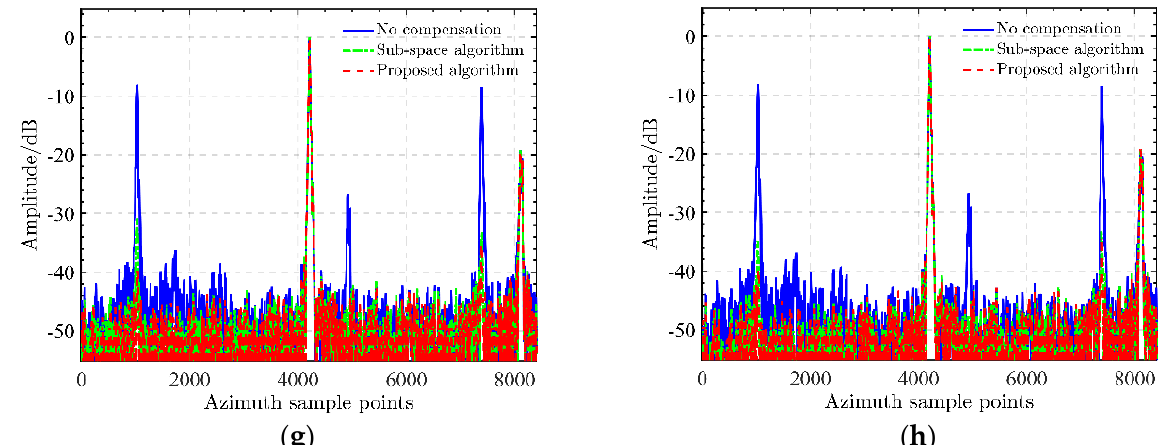
Figure 7. Azimuth ambiguity suppression of different calibrations under SNRs from − 15 dB to 20 dB. ( a ) Results under SNR = − 15 dB, ( b ) Results under SNR = − 10 dB, ( c ) Results under SNR = − 5 dB, ( d ) Results under SNR = 0 dB, ( e ) Results under SNR = 5 dB, ( f ) Results under SNR = 10 dB, ( g ) Results under SNR = 15 dB, (h) Results under SNR = 20 dB.